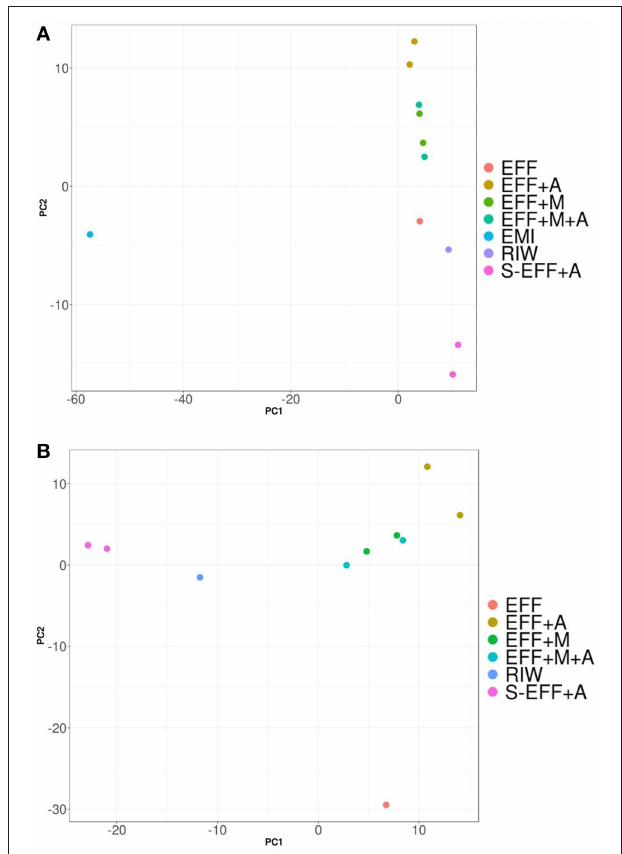
FIGURE 6 | (A) PCA graphs when all samples are present. Sample clustering was driven by enriched microbial inoculum. Since this sample contained highly diverse microbiota, it clustered away from all other samples. All photoheterotrophic samples clustered together indicating that the photoheterotropic treatment had similar effects on all samples regardless of the presence or absence of EMI or algal inoculum. (B) PCA graphs when excluding enriched microbial inoculum sample. There was low variation in taxonomic profile before and after dark fermentation. All photoheterotrophic samples had similar microbial community profiles.